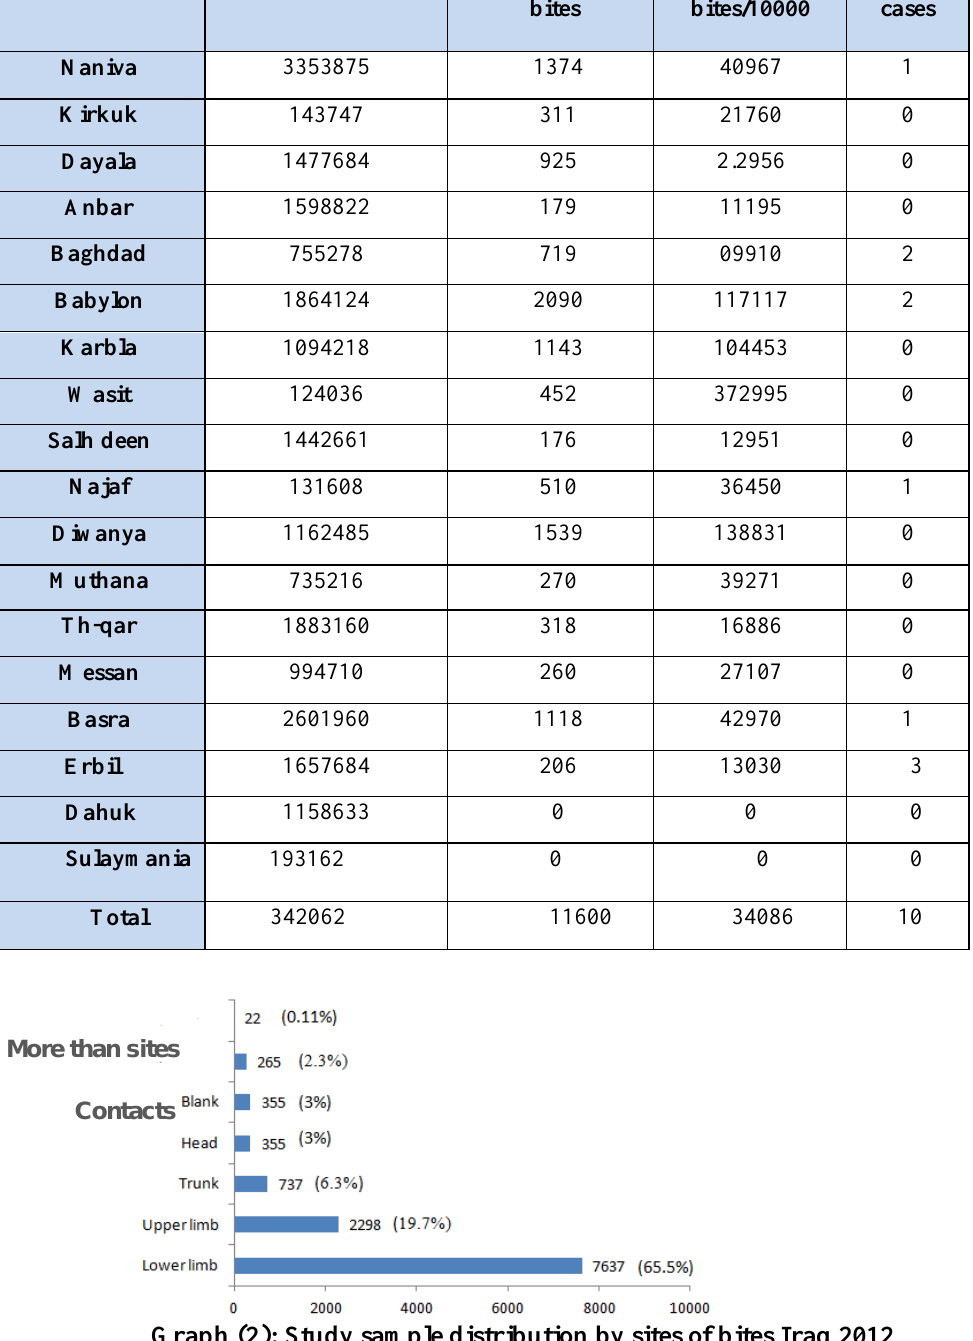
Graph (2): Study sample distribution by sites of bites Iraq